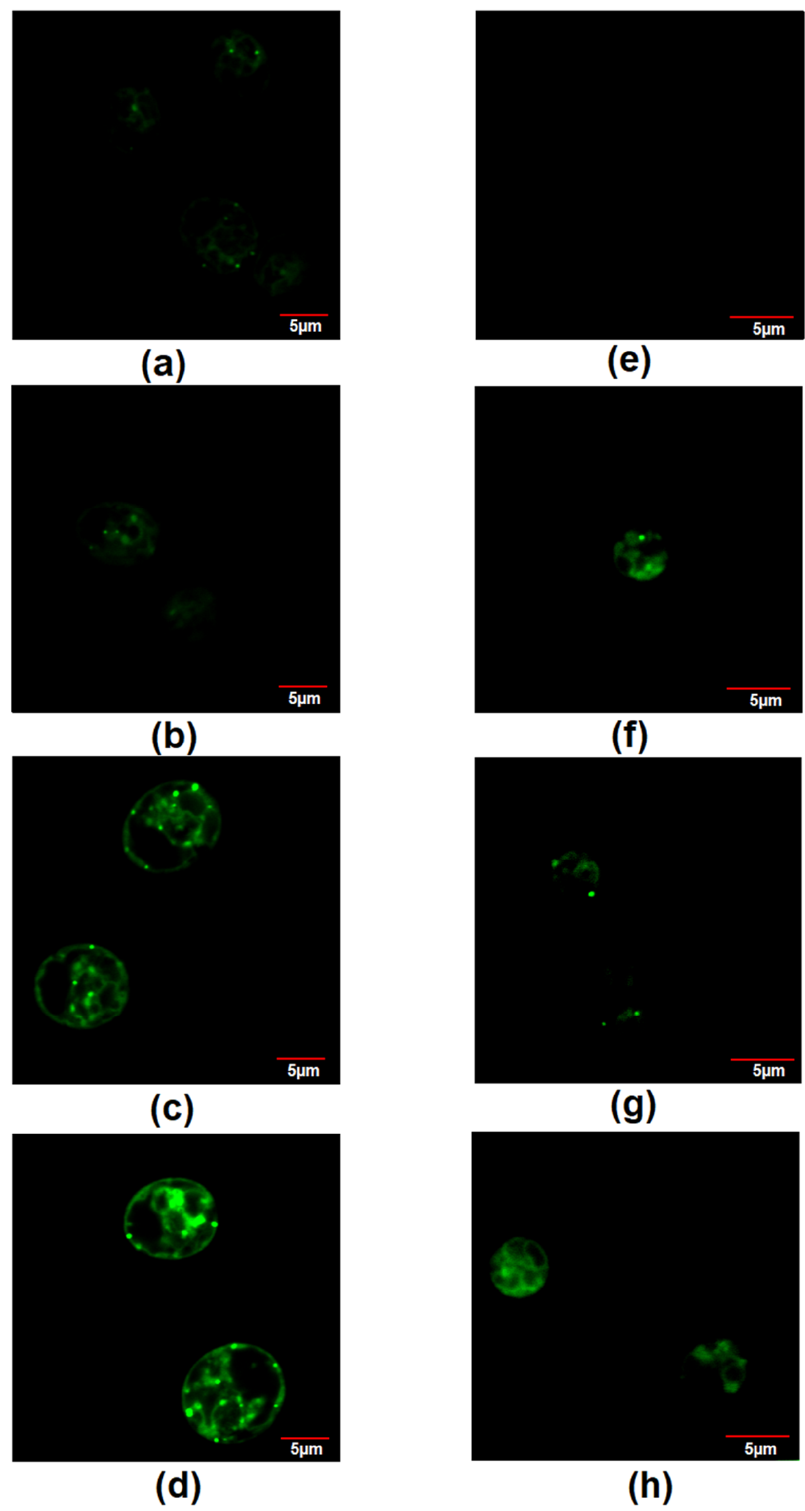
Figure 8. Staining of neutral lipids by BODIPY dye in Chlamydomonas sp. MACC-216 grown in TAP ( a ), TAP-M5 ( b ), TAP-M10 ( c ), TAP-M15 ( d ) and Chlorella sp. MACC-360 grown in TAP ( e ), TAP-M5 ( f ), TAP-M10 ( g ), TAP-M15 ( h ). 3.7. Chlorella sp. MACC-360 and Chlamydomonas sp. MACC-216 Efficiently Removed Nitrate from Synthetic Wastewater